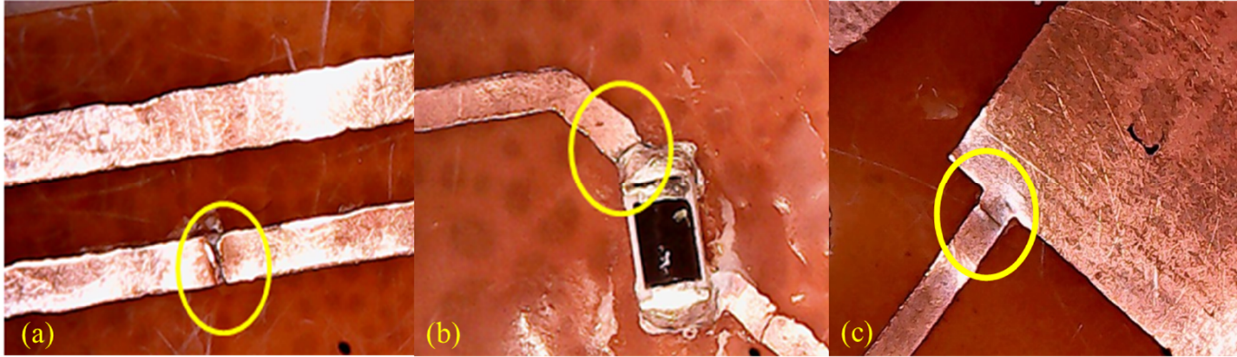
Figure 10. Percentage of samples with R’/R values above and below 2: ( a ) samples with SMD 0805; ( b ) samples with SMD 1205.